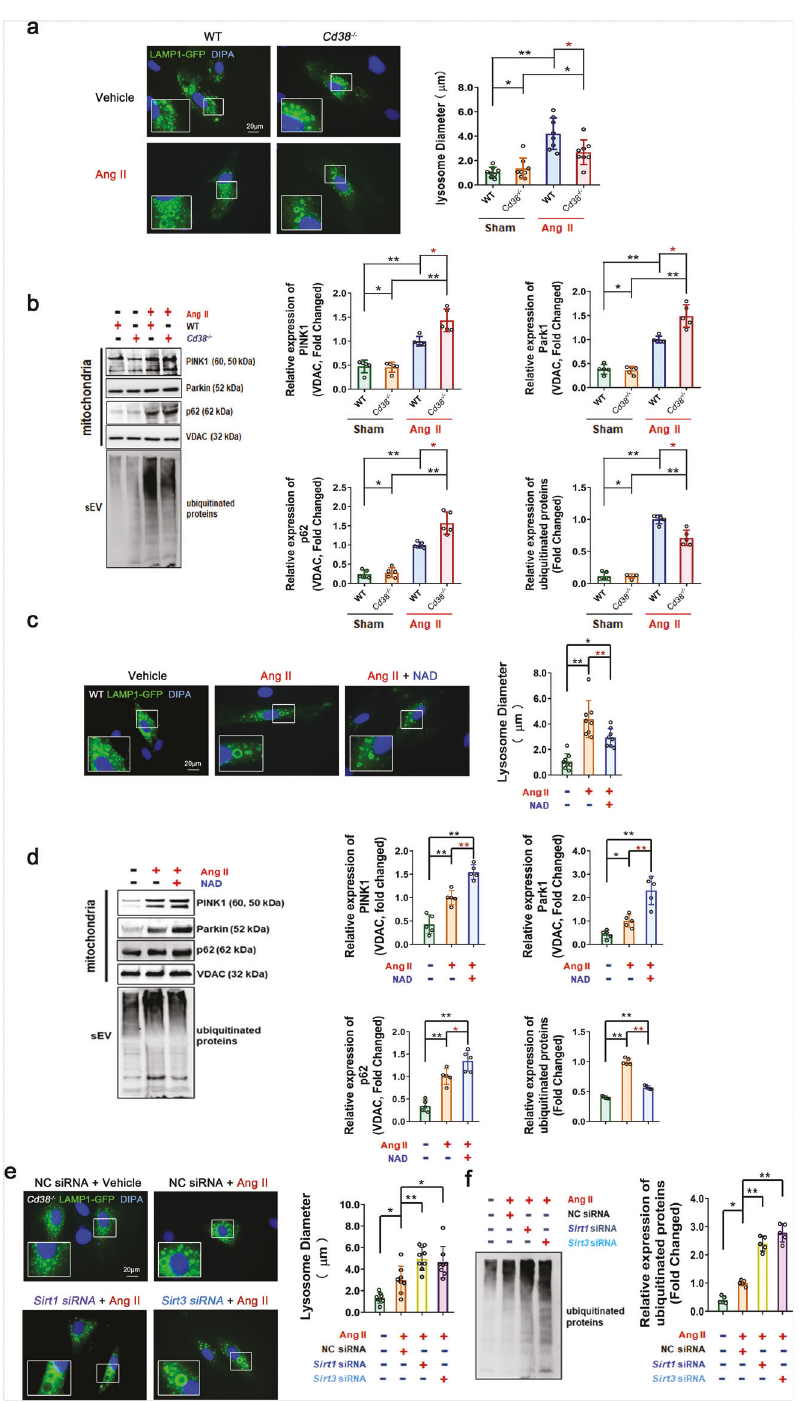
Fig. 7 CD38 de fi ciency prevented SA-sEV biogenesis in VSMCs by reestablishing the mitochondrial-lysosomal axis in a NAD/Sirtuin- dependent manner. a , b In vitro lysosome function and mitophagy analysis in VSMCs with or without CD38 de fi ciency. a WT and Cd38 − / − VSMCs were transfected overnight with the LAMP1-mGFP plasmid and treated with or without Ang II (100 nM) for 3 days. The green fl uorescing structures were tracked to lysosomes ( n ≥ 5, one-way ANOVA, * p < 0.05, ** p < 0.01). b The expression of mitophagy-associated proteins (PINK1, Parkin and p62) in mitochondria and ubiquitinated proteins in sEVs were analyzed by western blot assay. WT and Cd38 − / − VSMCs were treated with or without Ang II (100 nM) for 3 days ( n ≥ 5, one-way ANOVA, * p < 0.05, ** p < 0.01). c , d In vitro lysosome function and mitophagy analysis in WT VSMCs treated with NAD supplementation. VSMCs were transfected with LAMP1-mGFP plasmids and then treated with or without NAD (100 μ M) plus Ang II (100 nM). c Lysosomal structures were detected by cellular micro fl uorescence imaging. d The expression of mitophagy-related proteins in mitochondria and ubiquitinated proteins in sEVs were analyzed by western blot assay ( n ≥ 5, one- way ANOVA, * p < 0.05, ** p < 0.01). e , f In vitro lysosome function and mitophagy in Cd38 − / − VSMCs with or without Sirt1 or Sirt3 interference were analyzed. Cd38 − / − VSMCs were transfected overnight with siRNA or siRNA plus LAMP1-mGFP plasmids. Ang II (100 nM) was administered and maintained for 3 days. The lysosomal structures ( e ) and ubiquitinated proteins in sEVs ( f ) were detected by cellular micro fl uorescence imaging and western blot assay ( n ≥ 5, one-way ANOVA, * p < 0.05, ** p < 0.01) Signal Transduction and Targeted Therapy (2021)